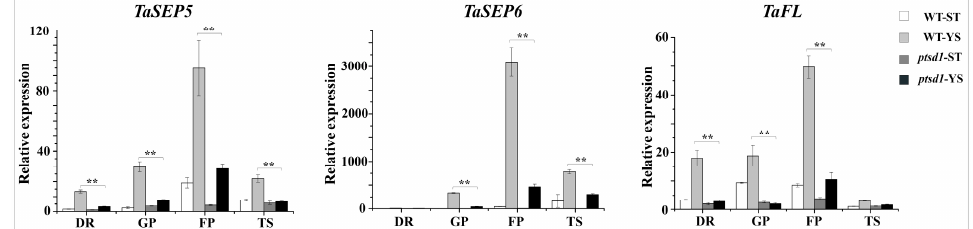
Figure 4. Expression patterns of three homeotic genes. Double ridge stage (DR), glume primordium visible stage (GP), floret primordium visible stage (FP) and terminal spikelet stage (TS). The asterisk indicates the significant difference between different samples (**: p ≤ 0.01).